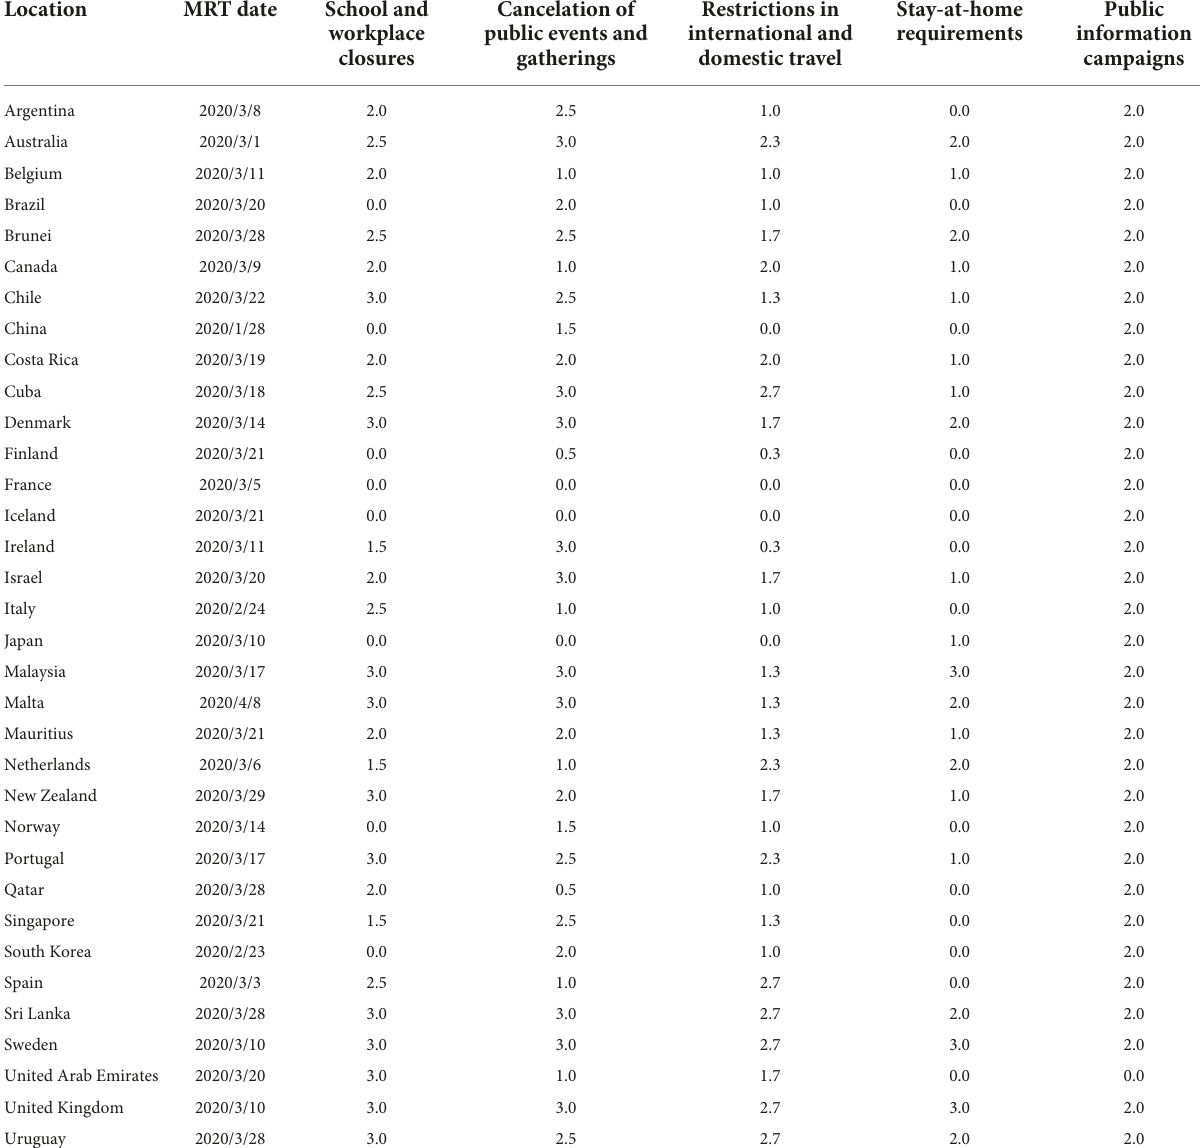
TABLE 1 Implementation of non-pharmacological intervention combinations at the date the COVID-19 mortality rate threshold was reached in 34 countries. Location